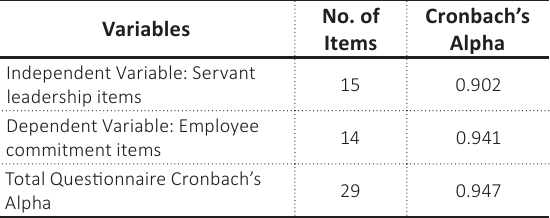
Table 1. Reliability